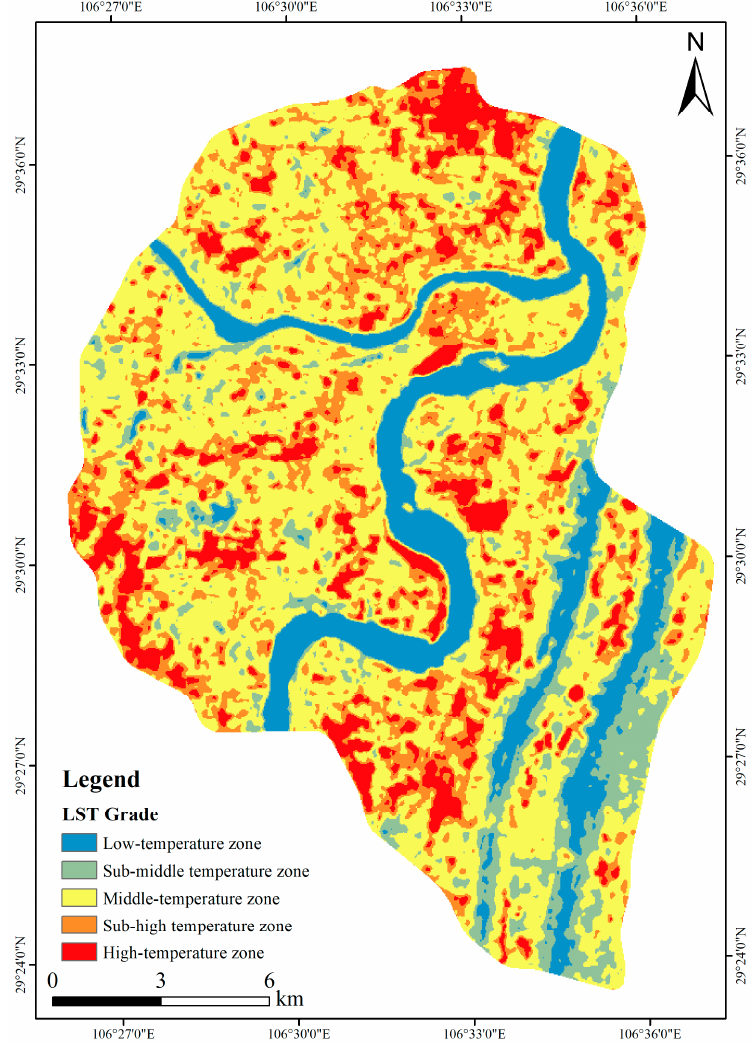
Figure 5. Different LST grades.